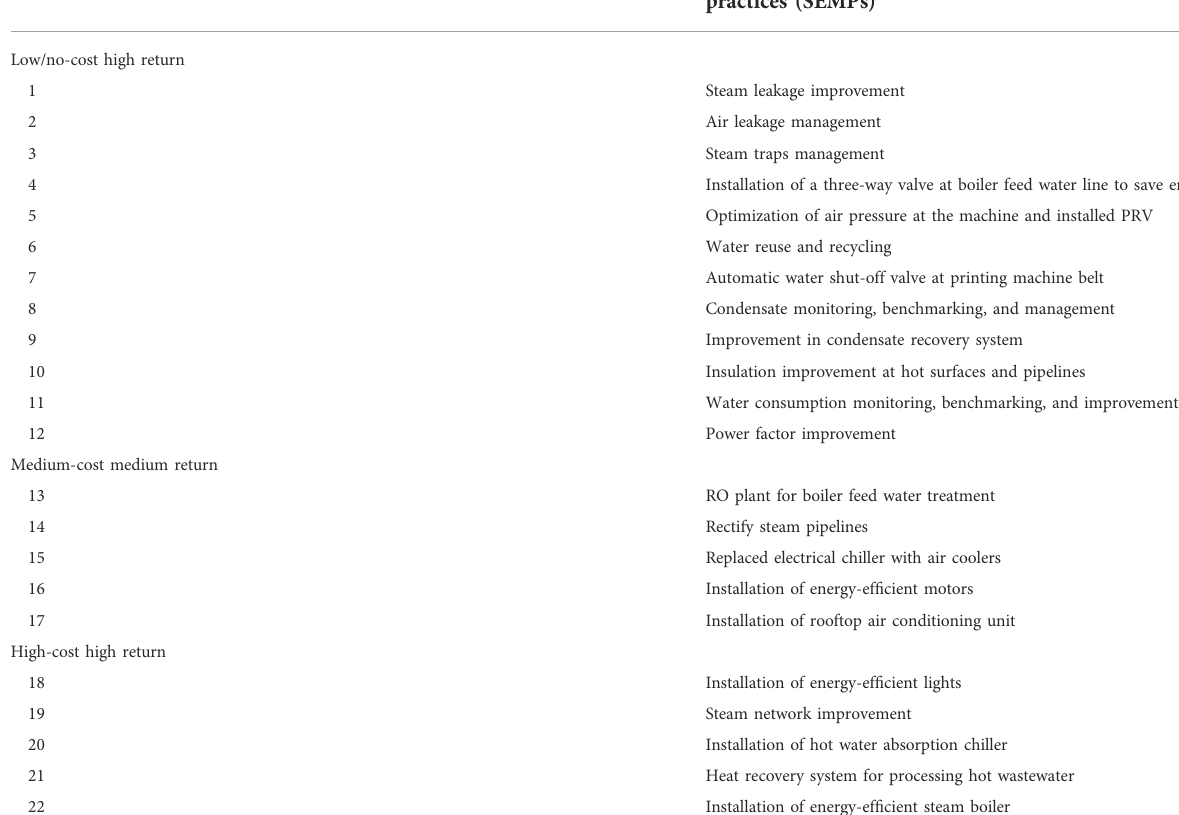
TABLE 10 Benchmarking of smart environmental management practices (SEMPs). S.